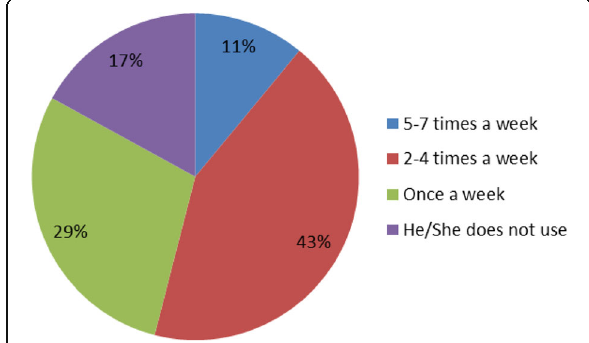
Fig. 12 The frequency of the use of sports facilities by children